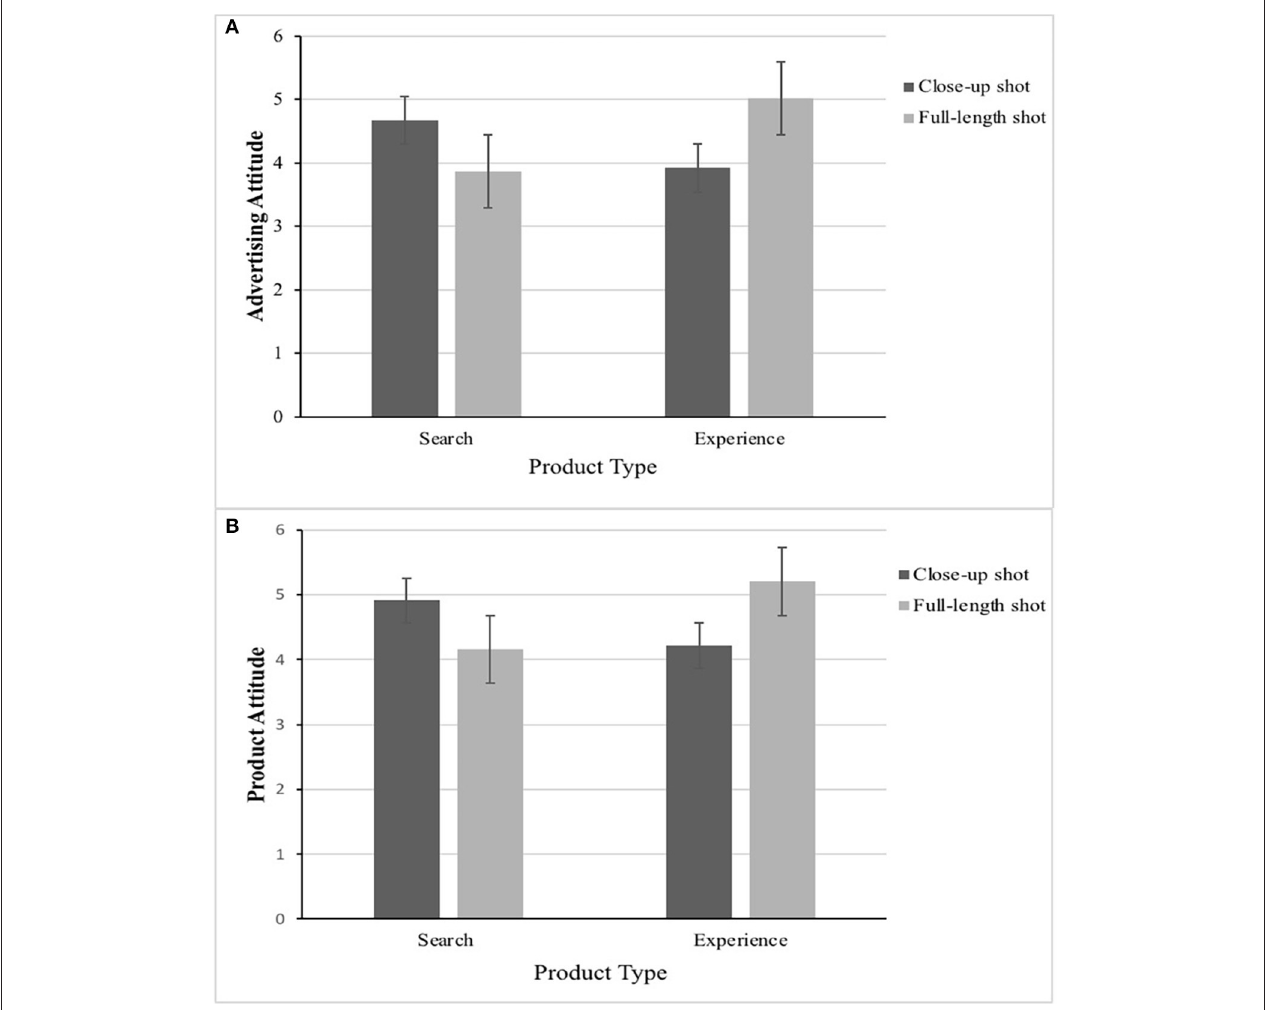
FIGURE 5 | The congruence effect between image proximity (close-up vs. full-length) and product type (search vs. experience) on advertising attitude (A) and product attitude (B) in Experiment 2.